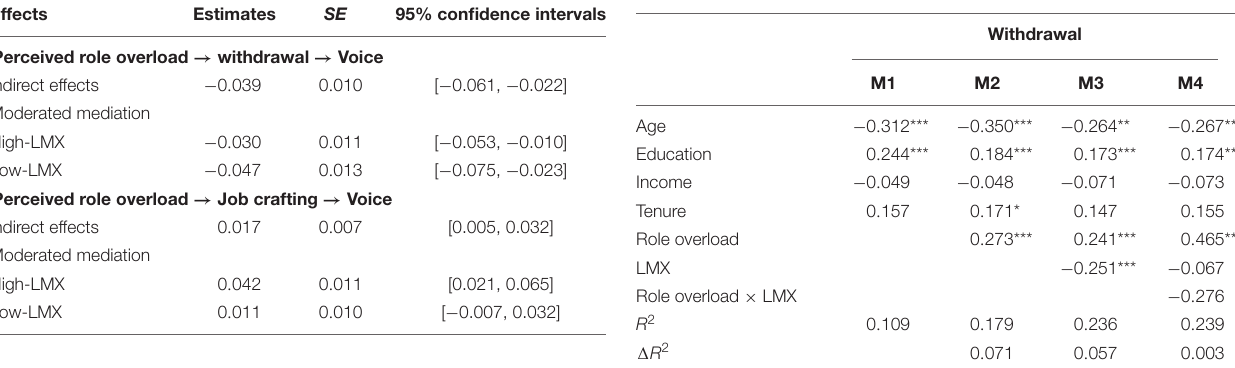
TABLE 3 | Summary of indirect effects and moderated indirect effects. TABLE 4 | Regression analyses for the effect of perceived role overload and